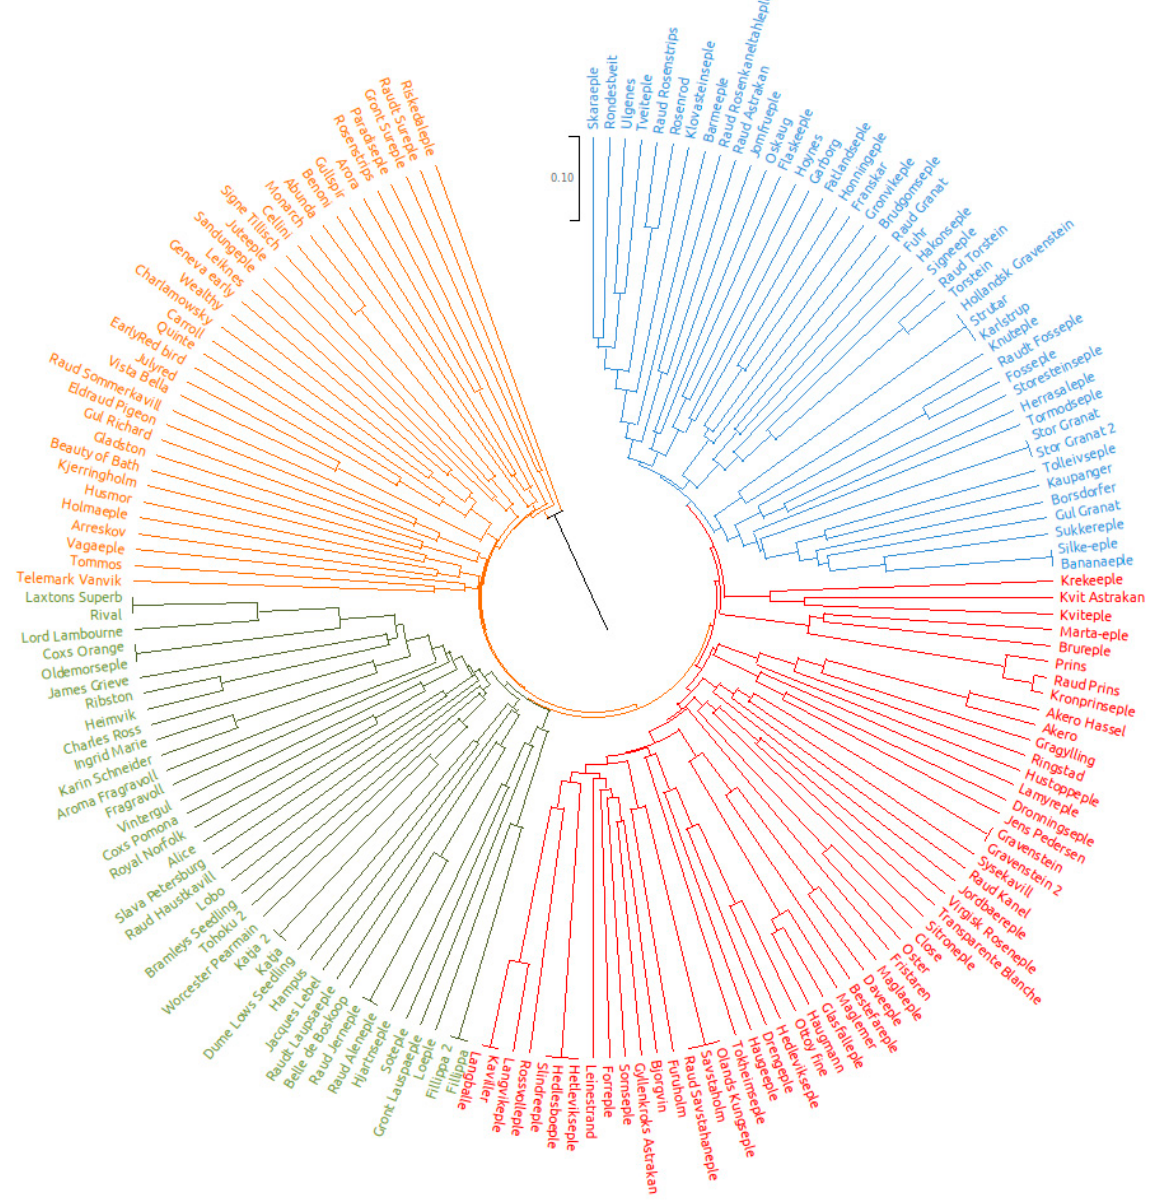
Figure 1. UPGMA cluster analysis based on polymorphisms of SSR data for 171 apple accessions using Jaccard’s similarity coefficient.